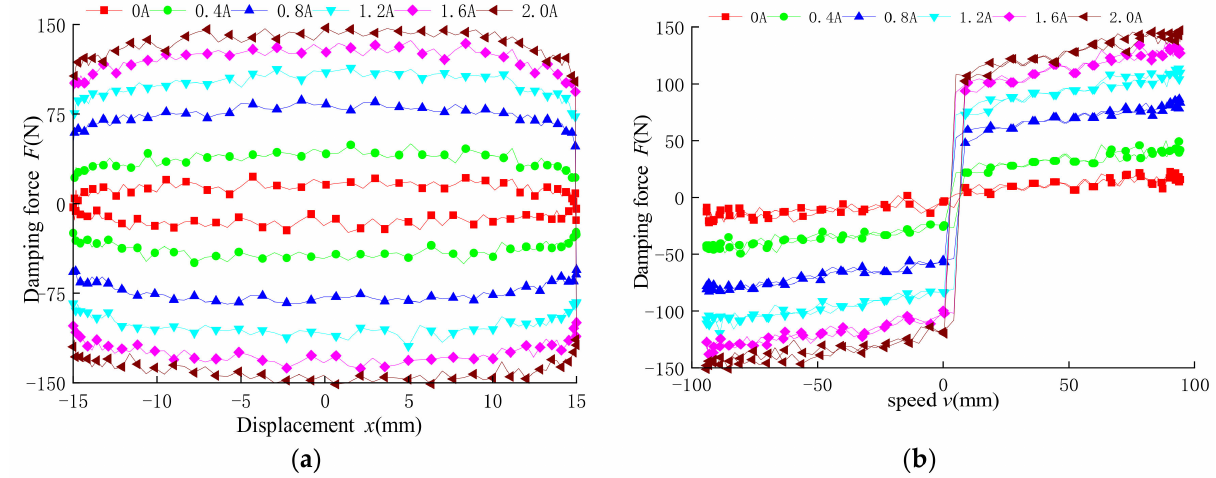
Figure 9. Dynamic performance of MR damper under different currents. ( a ) Damping force-displacement, ( b ) damping force-speed.